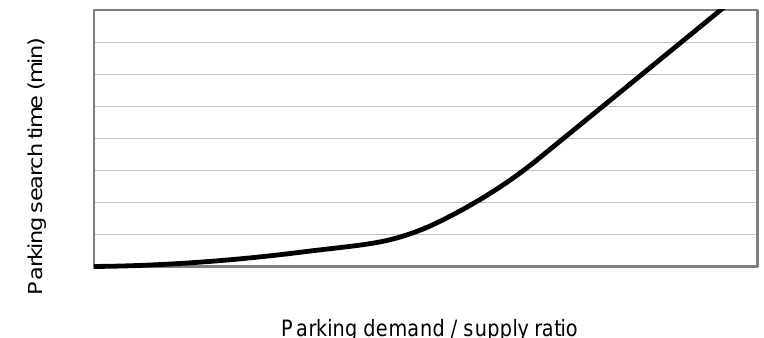
Figure 3. Function of parking search time in relation to demand / supply ratio In relation to the effects on the frequency of public transport, it is assumed that in the medium term operators keep a constant occupancy rate and therefore frequency is linearly proportional to the demand for public transport, while waiting time for public transport is inversely proportional to